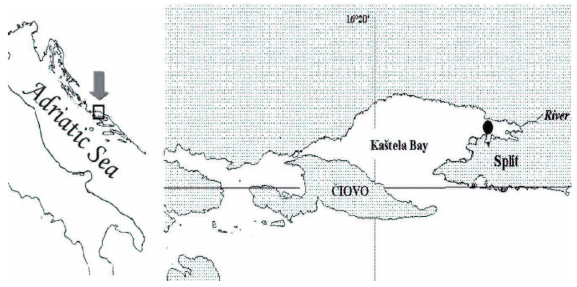
Fig . 1. – location of the sampling station in the Kaštela Bay (central adriatic